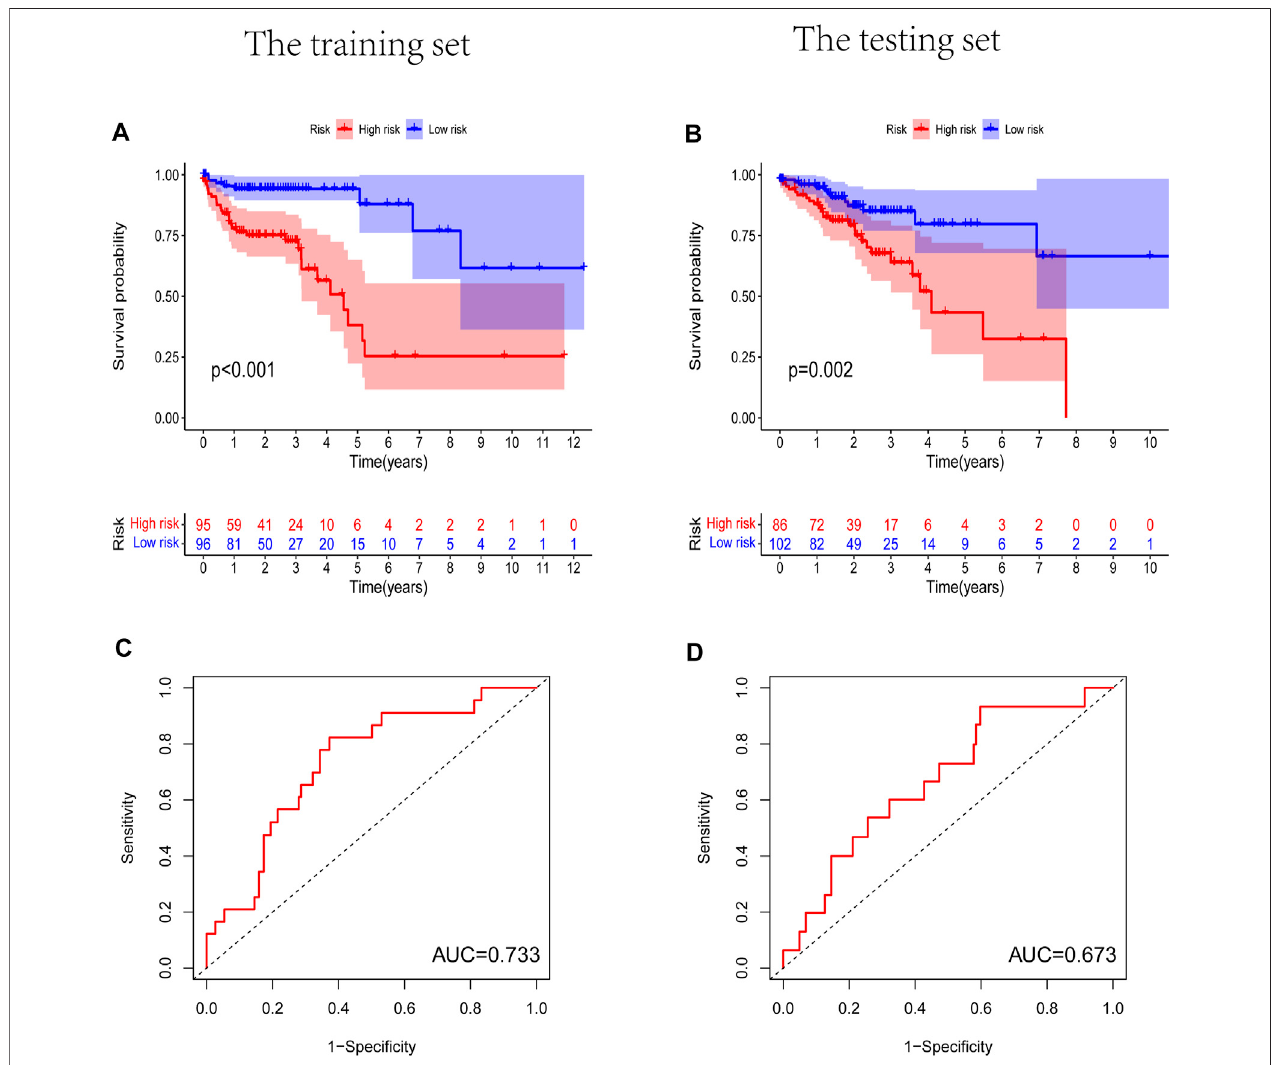
FIGURE 3 | The Kaplan-Meier survival curve analysis and the area under the ROC curve (AUC). (A,B) Survival curve of high- and low- riskgroups. ( p < 0.01). (C,D) ROC curve to evaluate the accuracy of our model. (AUC > 0.5). (A,C) Training dataset, (B,D) testing dataset.